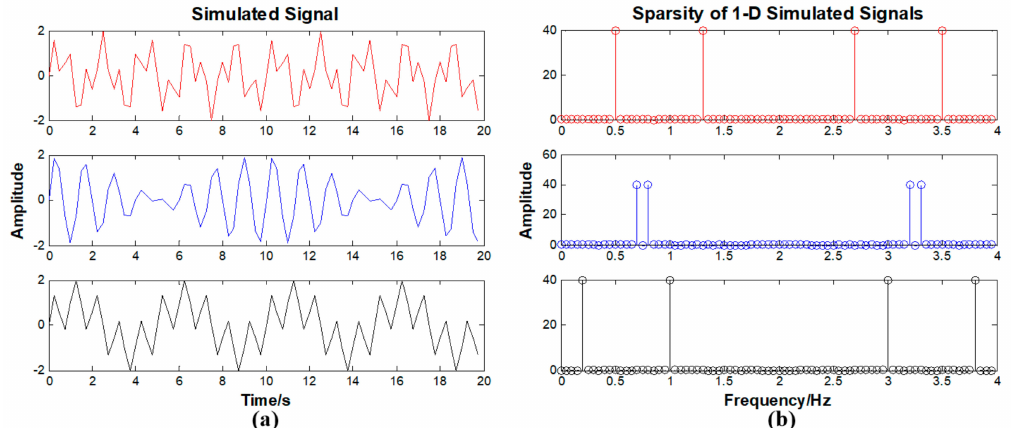
Figure 3. ( a ) Simulated 3-D equivalent bias angles signals. ( b ) Results of 1-D DFT for the 1-D equivalent bias angle